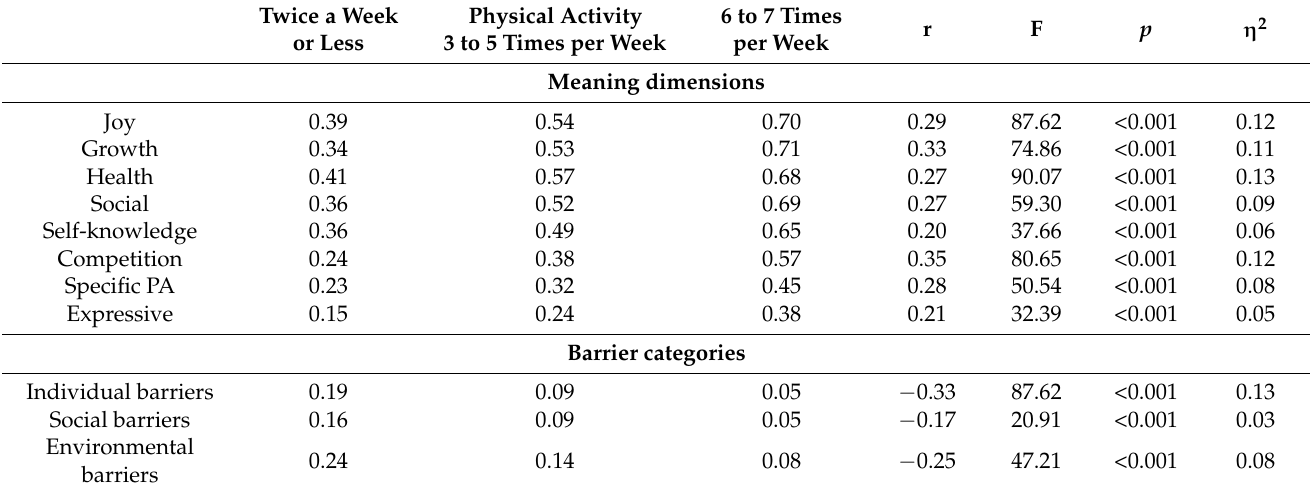
Table 4. Indexes of the number of important meanings according to meaning dimension and